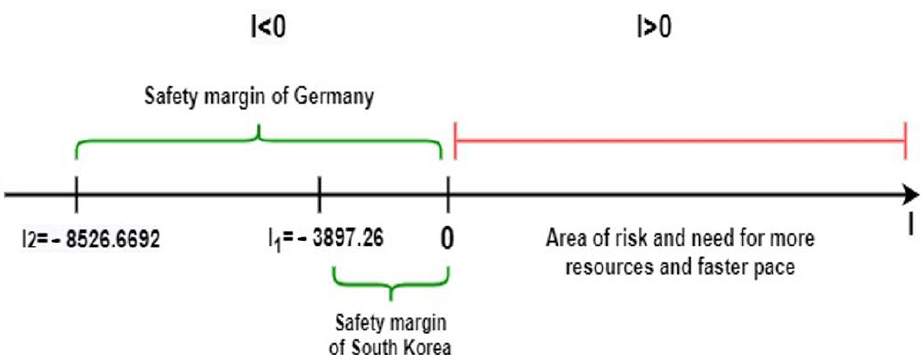
Figure 8. Visualization of smart city model effectiveness: safety margin and area of risk (South Korea and Germany). Source: made by authors.